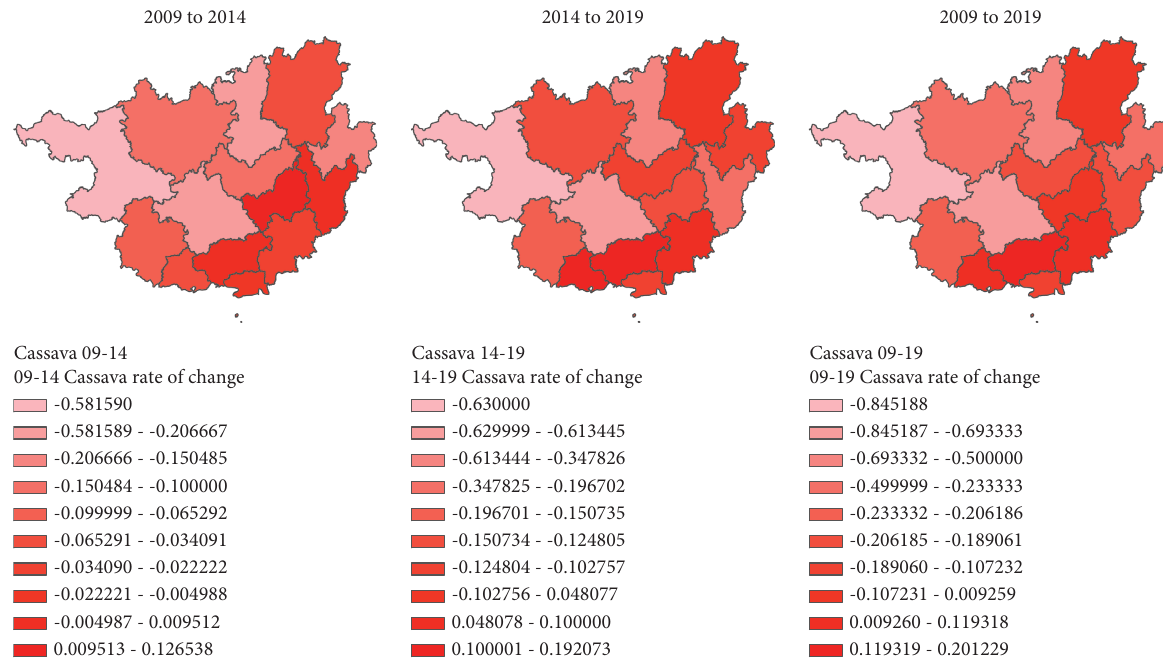
Figure 8: Change rate map of the proportion of cassava planting area in Guangxi from 2009 to